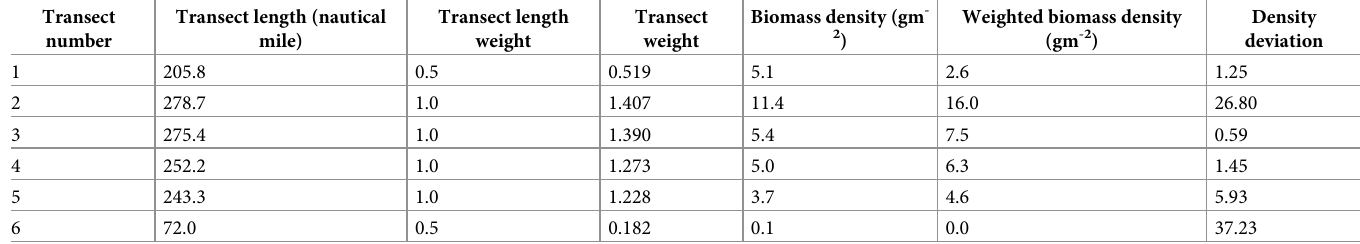
Table 2. Day and night data transect level results for the random sampling theory estimator. NB transects one and six are down weighted to account for the transect being placed on the Division eastern and western boundaries respectively (shown in the transect length weight). The transect weight column is the random sampling theory estimator transect weights (based on the reduced transect lengths). Surveying was carried out both day and